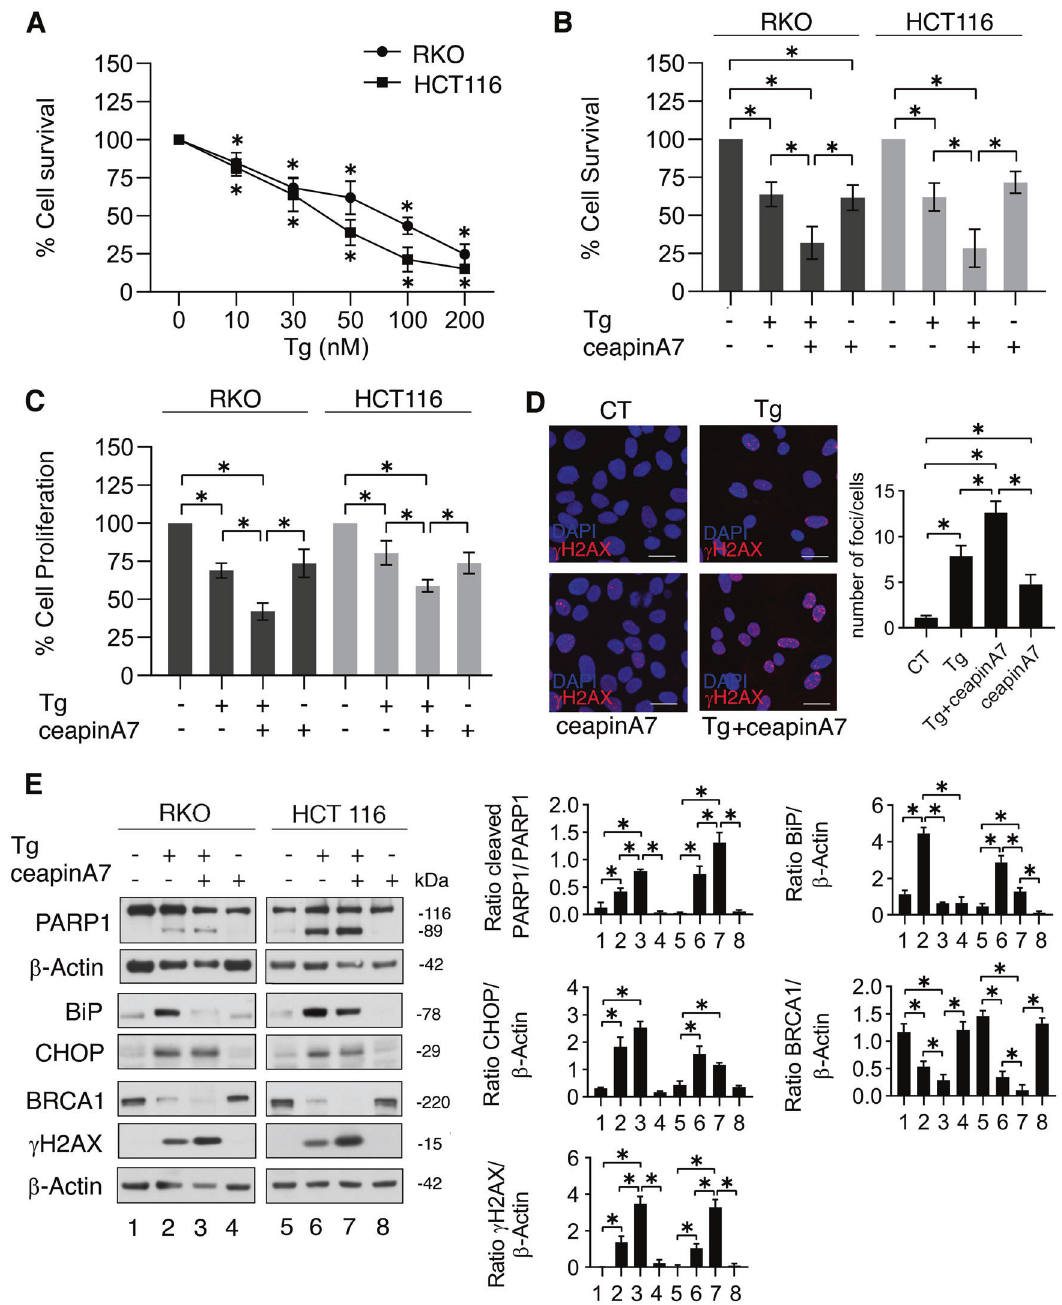
Fig. 2 ATF6 inhibition reduces survival, increases DNA damage, and reduces BRCA-1, although in Thapsigargin-stressed cells. A RKO and HCT116 cell lines were treated different doses of Thapsigargin (Tg) (10, 30, 50, 100, and 200 nM) or left untreated, as control. Cell viability was measured by a Trypan Blue exclusion assay after 48 h of culture, the dots represent the mean ± S.D. of live cells as percent of untreated control cells. p value: *<0.05. RKO and HCT116 cells were pre-treated or not with ceapinA7 (12 μ M) for 1 h and then treated or not with Thapsigargin (30 nM) or left untreated, as control. After 48 h of treatments, B cell viability was measured by a Trypan Blue exclusion assay, the histograms represent the mean ± S.D. of live cells as percent of untreated control cells. By using the KERN index (R), we found that the combination of Thapigargin and ceapinA7 induced a synergistic cytotoxic effect in both RKO and HCT116 cells (R > 1). C Cell proliferation was measured by MTT assay, the histograms represent the mean ± S.D. of the ratio between the OD of treated cells and control cells. p value: *<0.05. D γ H2AX foci (red) were assessed by IFA in RKO cell line. DAPI (blue) was used for nuclear staining. One representative experiment out of three is reported. The histograms represent the mean plus S.D. of the number of foci/cell from three different experiments. Bars = 20 μ m. p value: *<0.05. E Protein expression level of PARP cleavage, BiP, CHOP, BRCA-1, and γ H2AX was evaluated by western blot analysis. β -Actin was used as loading control and one representative experiment is shown. The histograms represent the densitometric analysis of the ratio of speci fi c protein and the appropriate control of three different experiments. Data are represented as the mean plus S.D. p value: *<0.05.